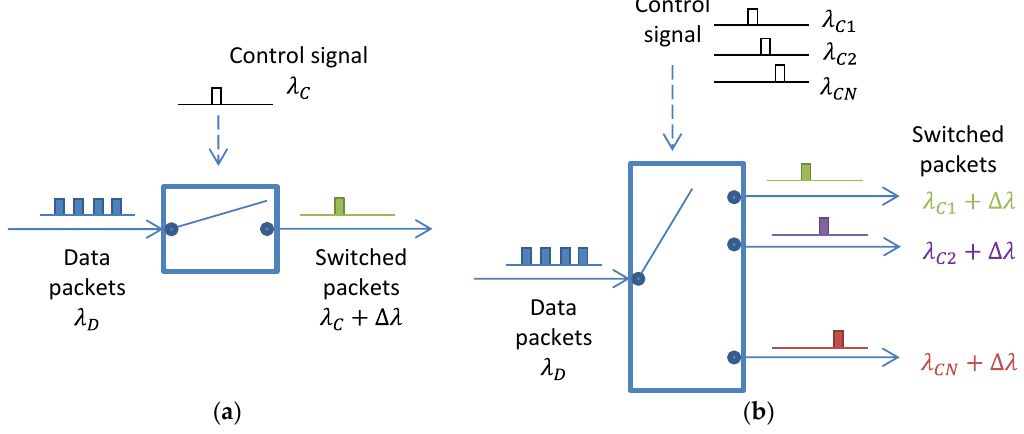
Figure 10. Schematic representation of the packet switching technique proposed by Hu et al. [75]: ( a ) one control wavelength; ( b ) different control wavelengths.